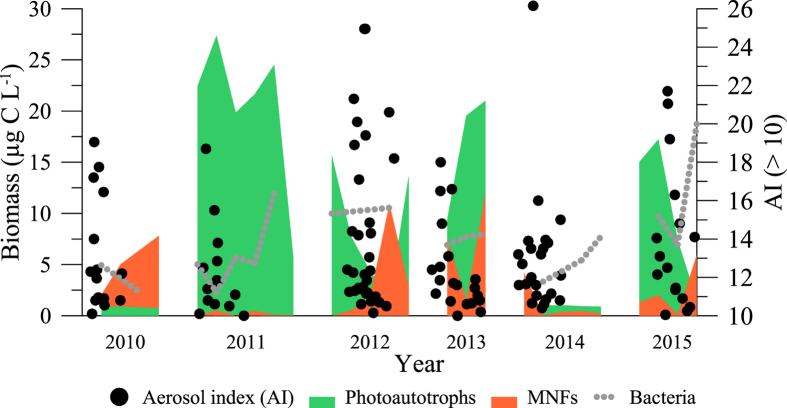
Dynamics of the biomass contribution (in μg C L−1) of main phytoplankton groups (mixotrophic nanoflagellates [MNFs, orange area] and photoautotrophs [green area]) and bacterial community [gray dotted line]) and aerosol index (AI in relative units, solid circles) with events >10 for the 2010–2015 ice-free period (from 1 June to 15 November) in lake La Caldera.Note that AI > 10 is a measure of intense atmospheric dust deposition inputs and that frequency is denoted with the degree of clustering of solid circles.